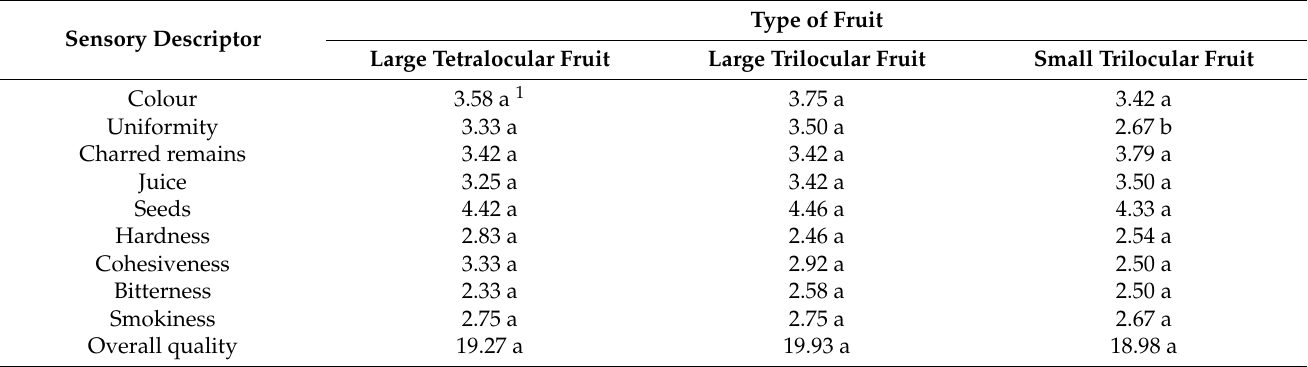
Table 4. Effect of morphological characteristics of the fruit on sensory properties of roasted